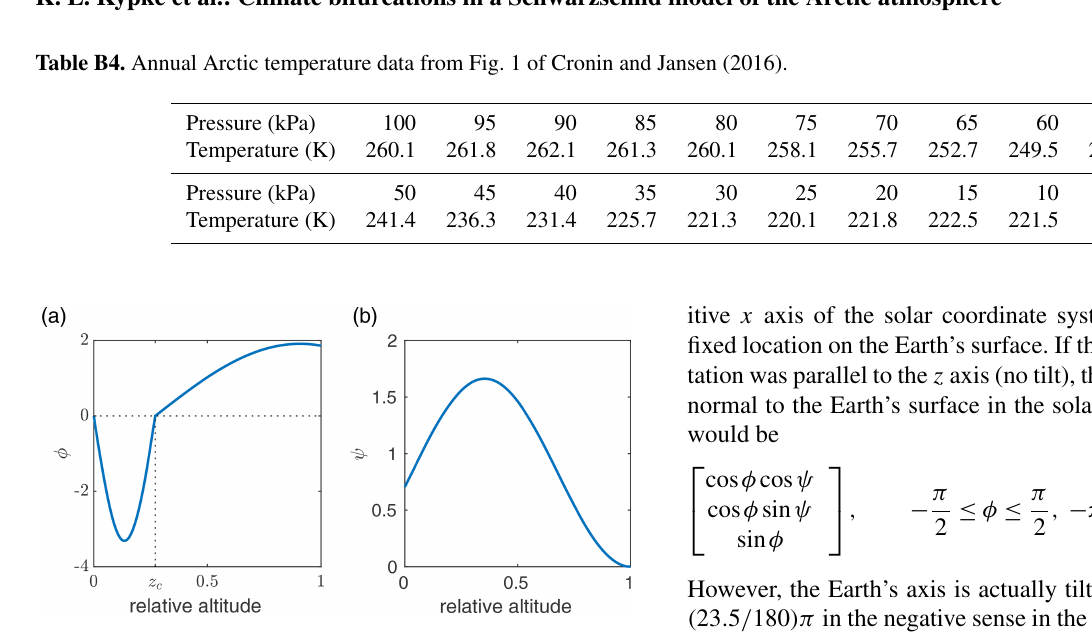
Figure B3. Calibrated functions: (a) φ and (b) ψ